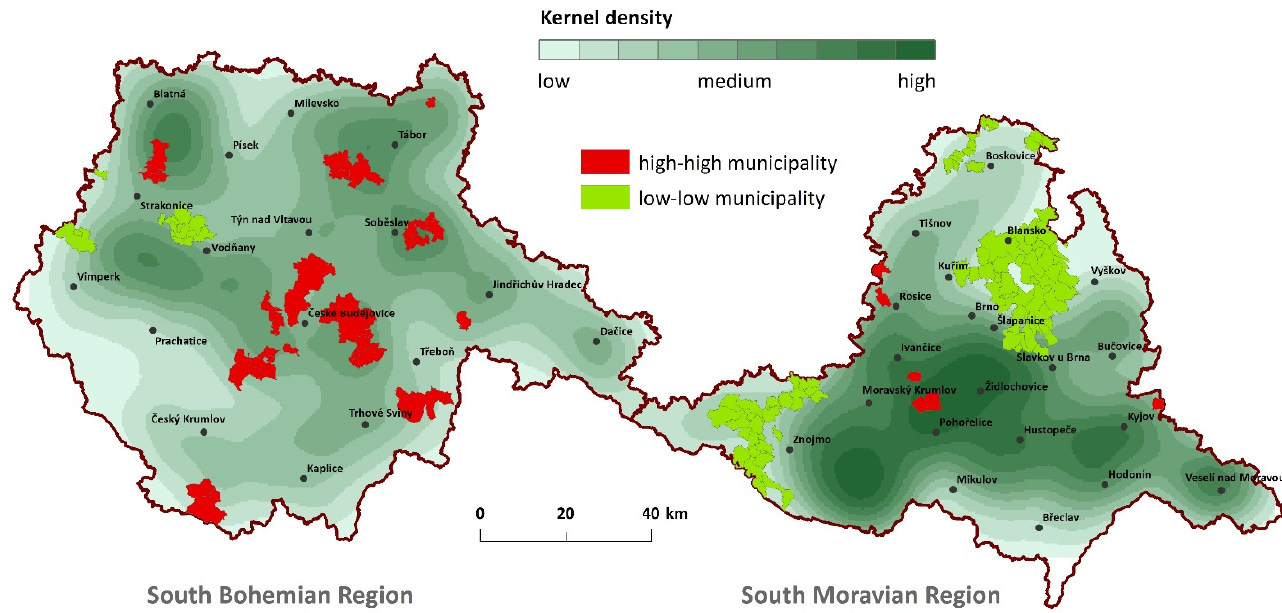
Figure 2. Location of the clusters of regions with the high-high (red) and low-low (green) occurrence of post-agricultural brownfields in the year 2004 (based on the application of the Anselin Local Moran’s I method) on iso-lines calculated by the Kernel density estimation. A geographical description of the area can be found in Figure 1.